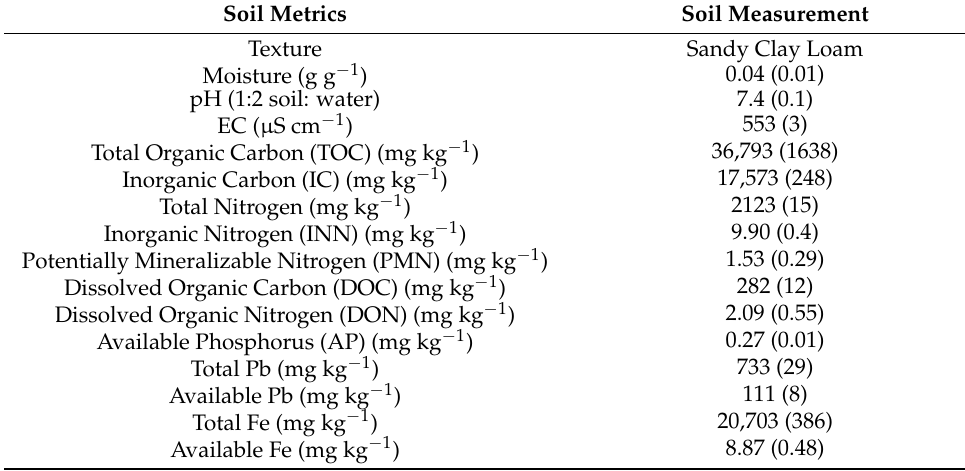
Table 1. Characteristics of native soil collected at beginning of pre-incubation. Data presented as average values with standard error in parentheses ( n =